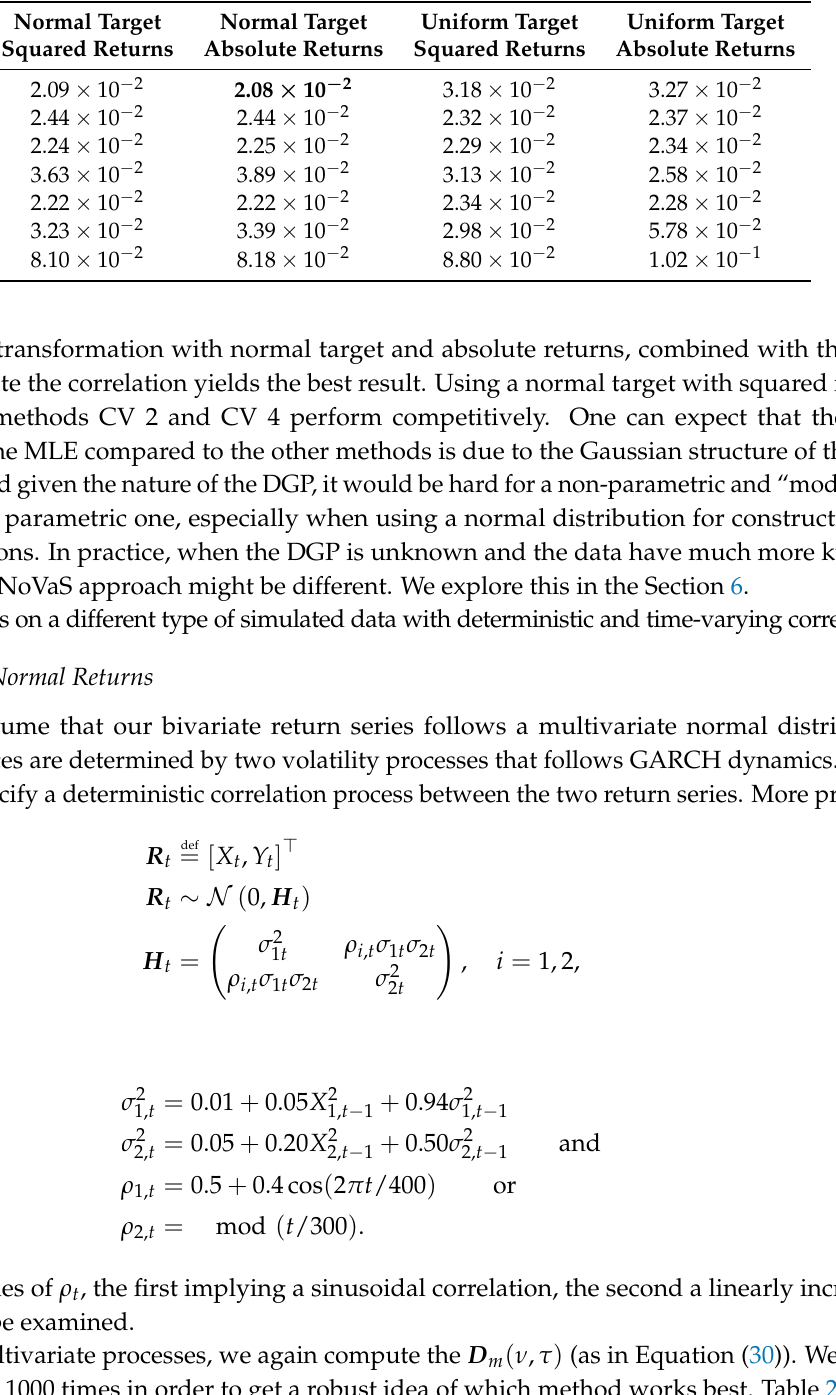
Table 1. Model selection on DGP-PS, 1000 iterations. Table entries are the MSE between ρ t | t − s and ˆ ρ t | t − s . Smallest MSE is presented in bold